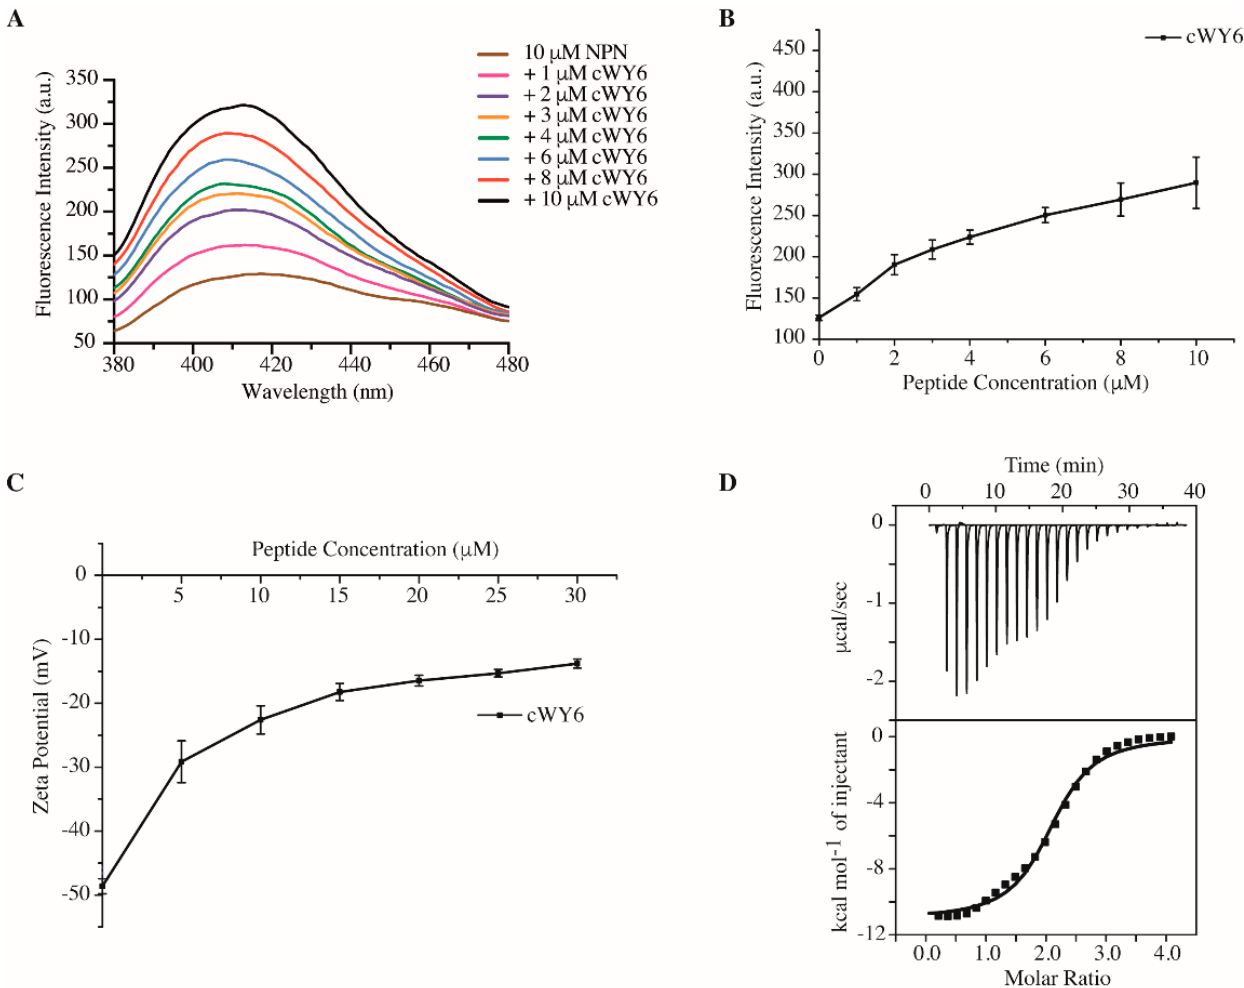
Figure 3. ( A ) Fluorescence emission spectra of NPN in solutions containing E. coli cells at increasing concentrations of cWY6 peptide. ( B ) Plot showing increase in fluorescence intensity at the emission maxima of NPN as a function of concentration of cWY6 peptide. ( C ) Plot showing zeta potential values of E. coli cell solutions containing increasing concentrations of cWY6 peptide. ( D ) ITC thermogram of interactions between cWY6 peptide and LPS. The top panel of ITC plot shows titrated peaks as function of time, whereas the lower panel delineates data fitting of integrated heat values at each point. Figure 3C delineates zeta-potential measurements of E. coli cells at various concentra- tions, 5 to 30 µ M, of the cWY6 peptide. Peptide additions caused a significant decrease in the zeta-potential values of E. coli cell solutions. The data suggest that the cWY6 peptide is able to neutralize the surface charge of Gram-negative bacteria. Further, interactions and thermodynamics of cWY6 peptide binding to LPS are quantified by isothermal titration calorimetry (ITC) experiments (Figure 3D). LPS–peptide interaction is exothermic in